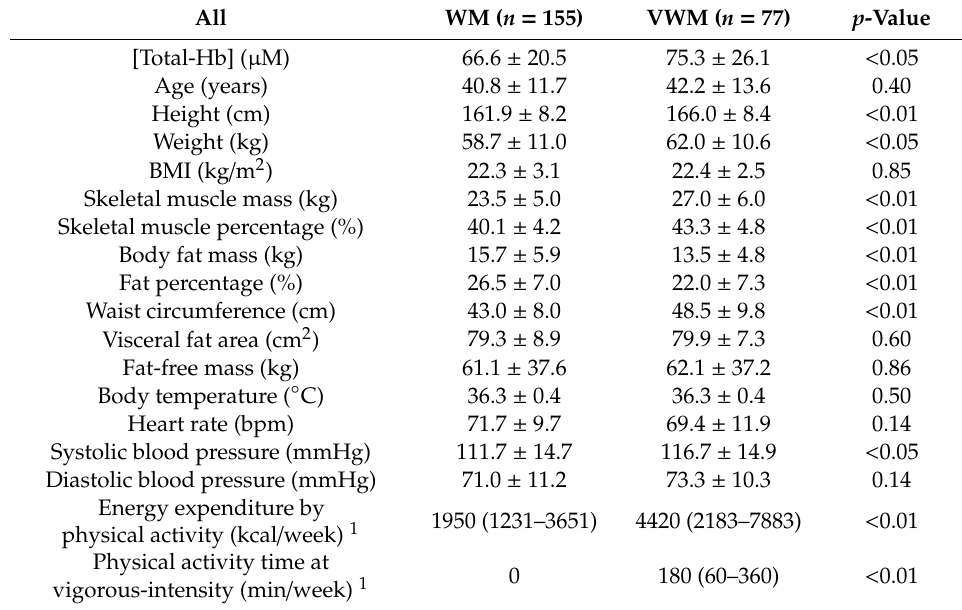
Table 1. Group comparisons for each parameter in men and